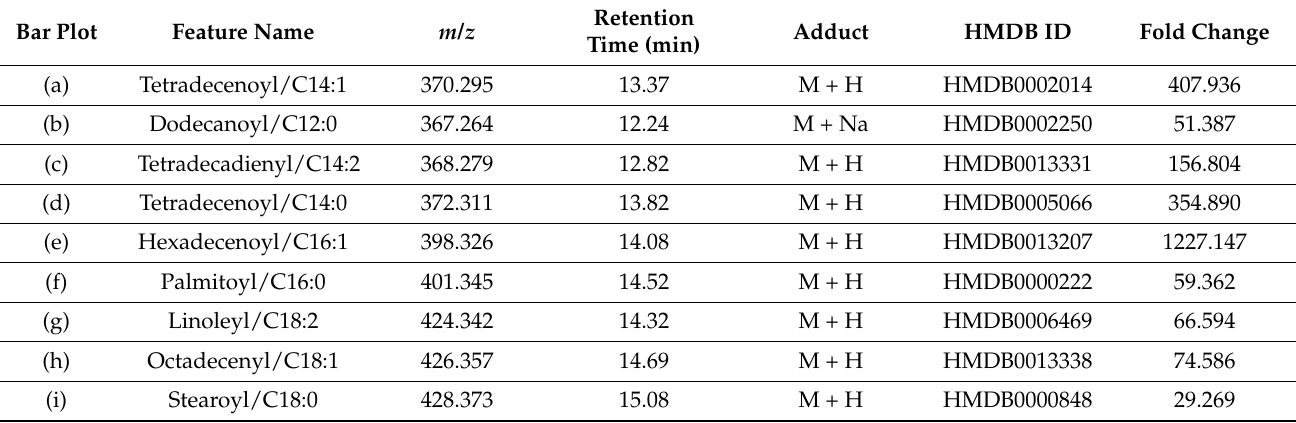
Table 2. List of carnitine esters observed to be perturbed after processing and analyzing the acquired patient sample data using the NGMS computational